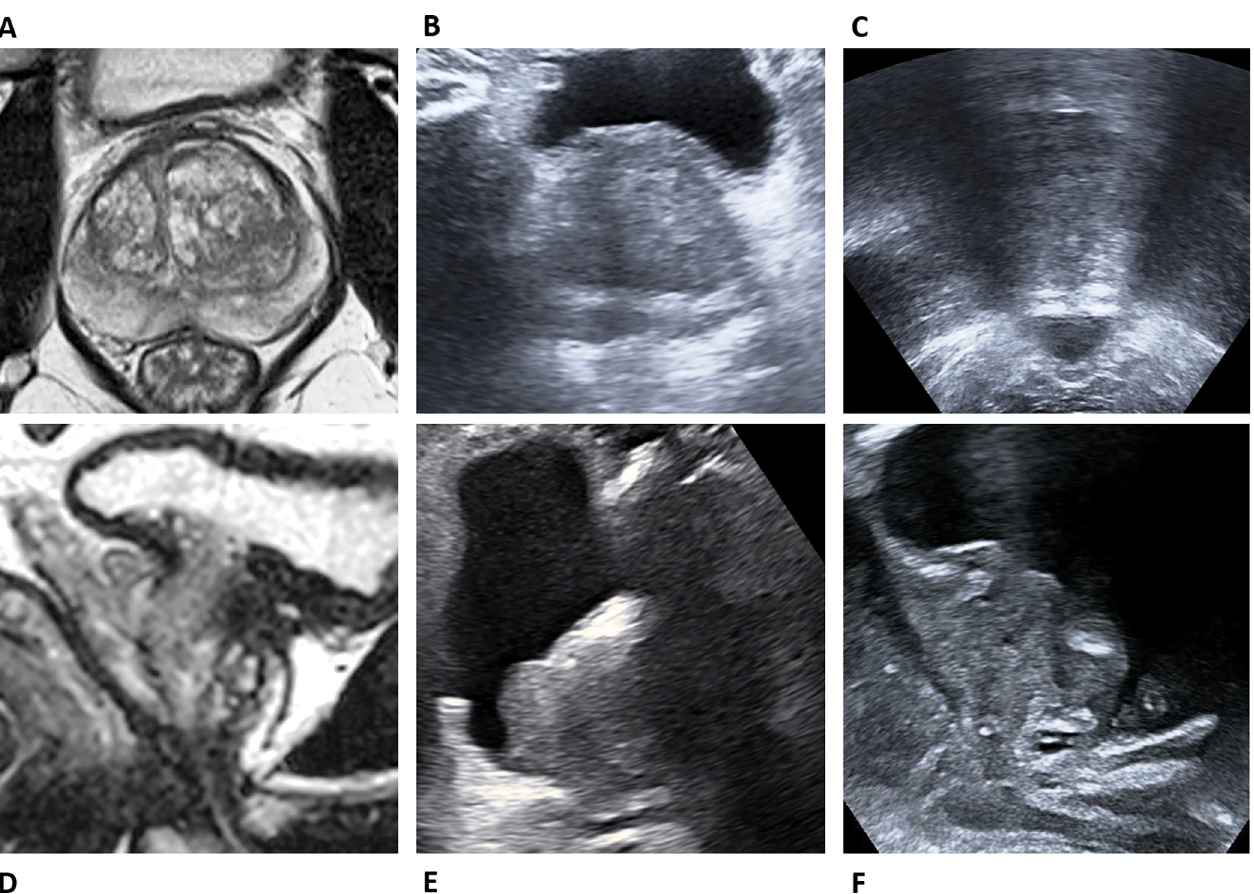
Fig 2. Example Transabdominal (TA) and Transperineal (TP) US views. Axial (A) and sagittal (D) MR images. B, E: TA ultrasound views from the same patient in the axial (B) and sagittal planes (E). C, F: TP ultrasound views in the axial (C) and sagittal planes (F). The sagittal TA US view (E) has shadowing from the pubis bone overlying the prostatic apex, which may affect measurement accuracy, conversely shadowing affects the axial view of TP imaging (C).